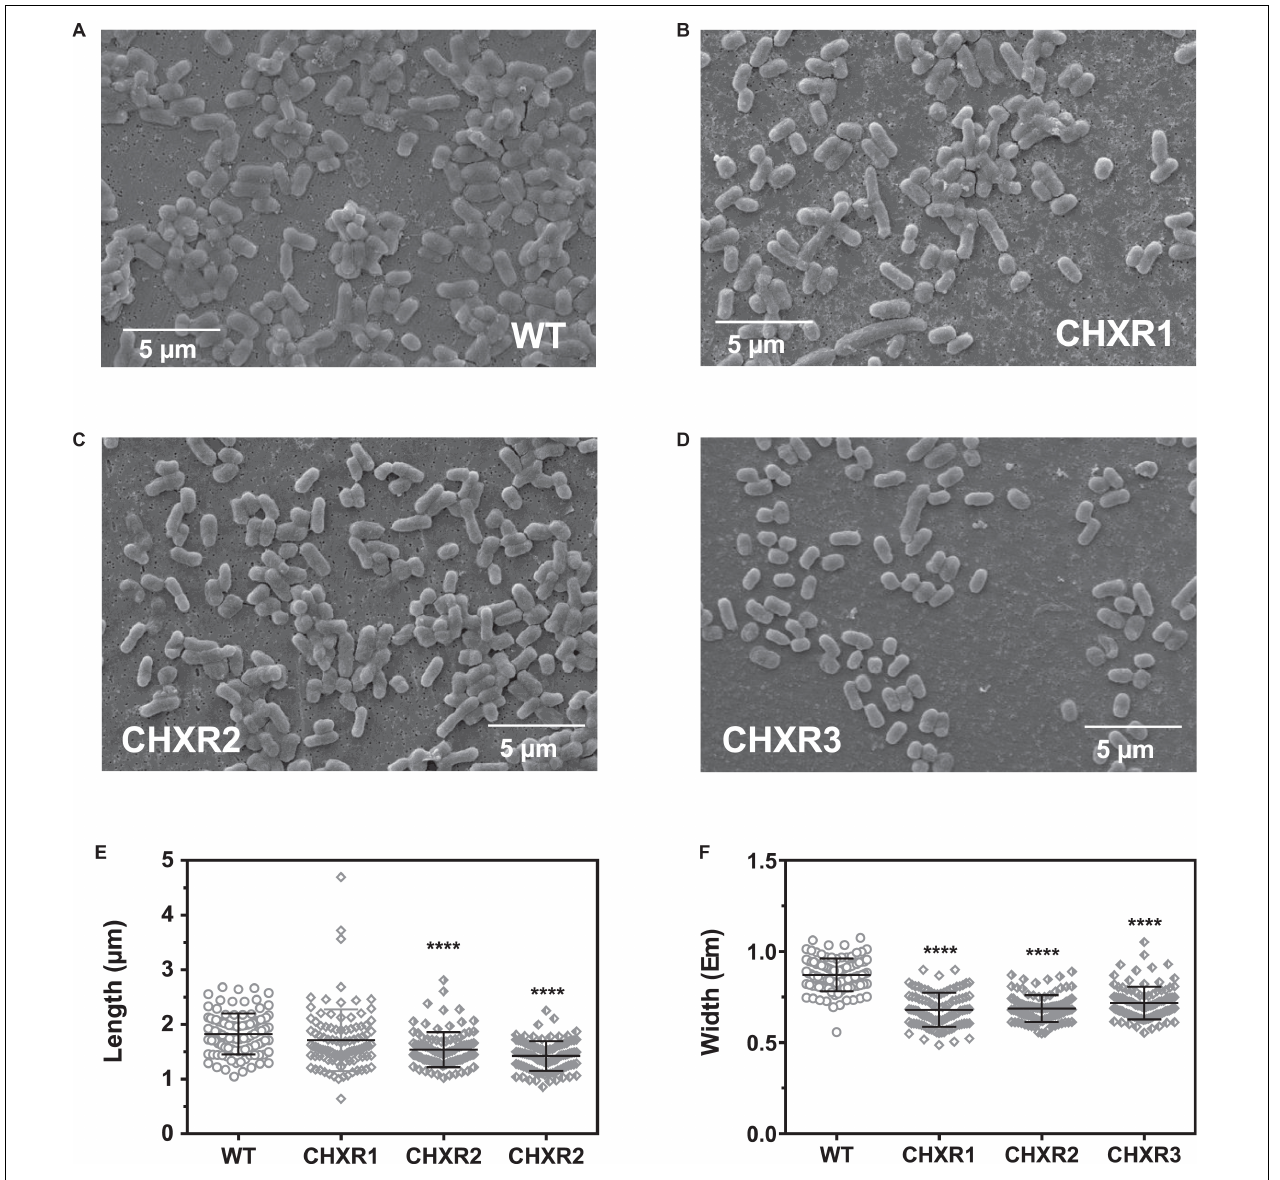
FIGURE 2 | Scanning electron microscopy (SEM) images of CHXR isolates and a summary of measured CHXR cell lengths and widths. (A–D) Show representative 5,000X magnification SEM images of WT (A) , CHXR1 (B) , CHXR2 (C) , and CHXR3 (D) cells. Bars shown in each panel indicate a 5 µ m length as a size reference. (E,F) Indicate a summary cell lengths (E) and widths (F) in µ m of 200 cells ( n = 200) and are shown as plotted symbols. Each CHXR isolate or WT was measured from five SEM images collected from each biological replicate using ImageJ software v1.8.0 measurement tools. Bar plots overlaid on measured cells indicates the maximum, median, and minimum interquartile ranges of the cell measurement datasets and asterisks (****) indicate significant differences between the WT and each CHXR isolate median values at P -values <